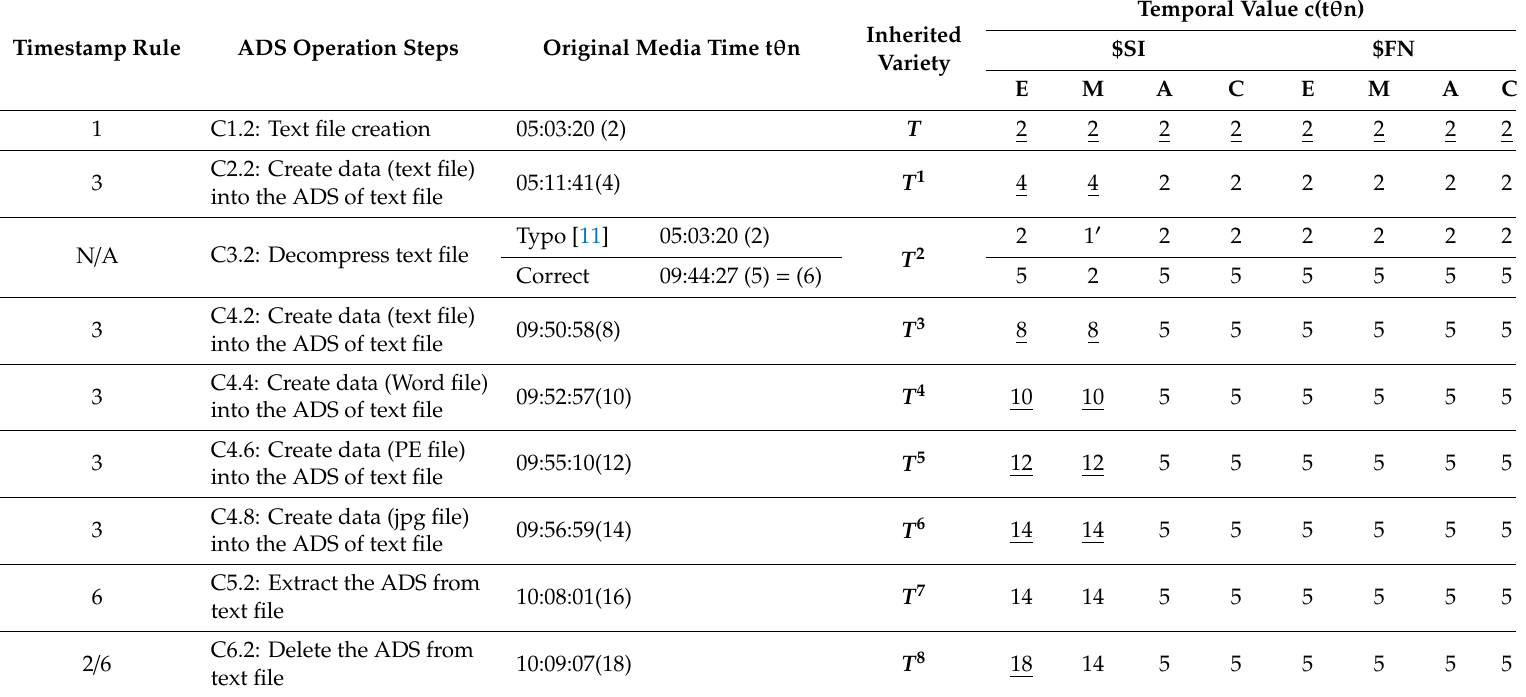
Table 13. Timestamp observation on text ADS